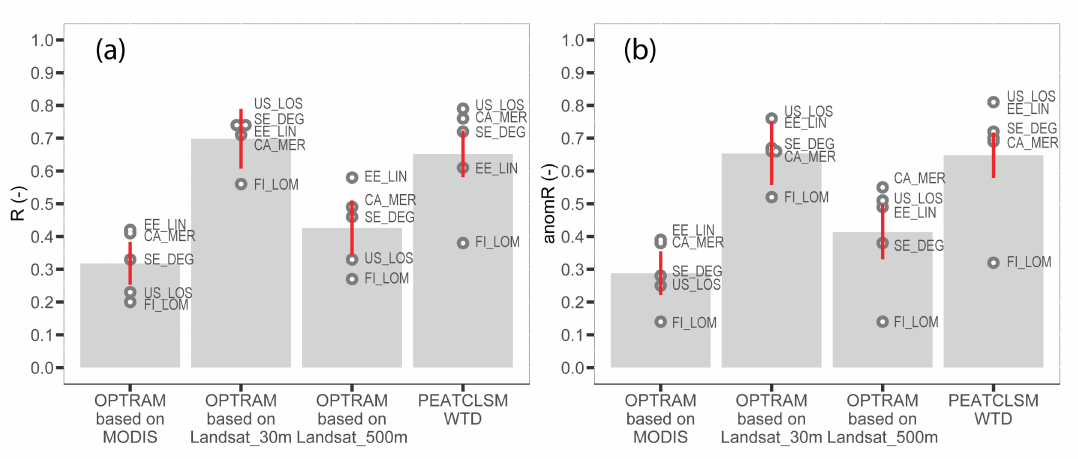
Figure 6. Temporal Pearson correlation coe ffi cients between in situ water table depth (WTD) and three versions of OPTRAM as well as PEATCLSM WTD for ( a ) original (R) and ( b ) anomaly (anomR) time series data. R and anomR are shown only for pixels with the highest R value within each peatland site, i.e., the ‘best pixel’, and for PEATCLSM WTD and in situ WTD (data taken for the same days as for estimating R between in situ WTD and OPTRAM based on Landsat_30m). The black dots and text on the right-hand side of these dots present the R and anomR values of the selected pixel and site code where this pixel is located. The height of the bars indicates the mean value of R and anomR. The error bars represent the 95% confidence intervals after having taken into account the temporal autocorrelation. The abbreviations of peatlands are given in Table